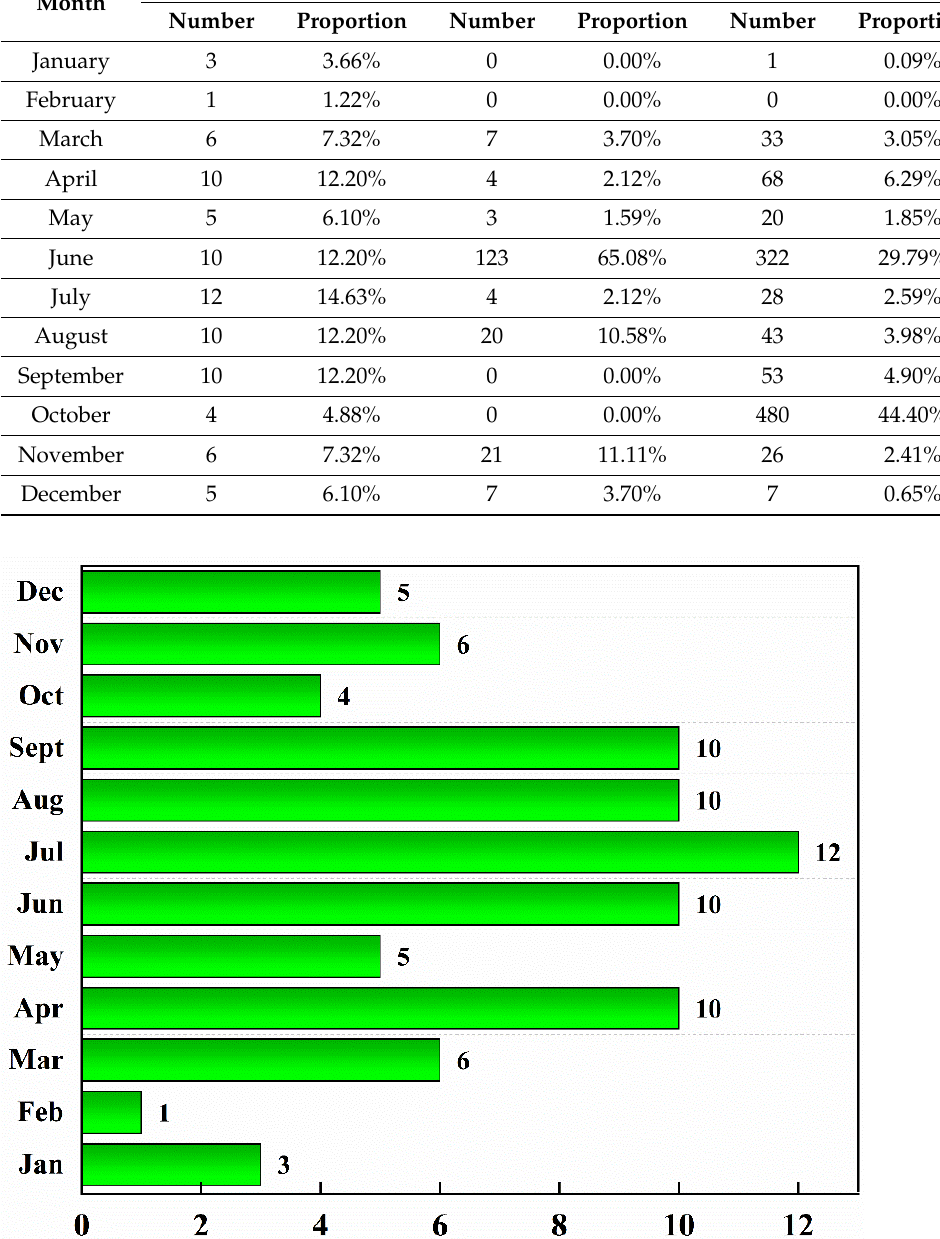
Figure 3. Monthly evolution of ArRAs.